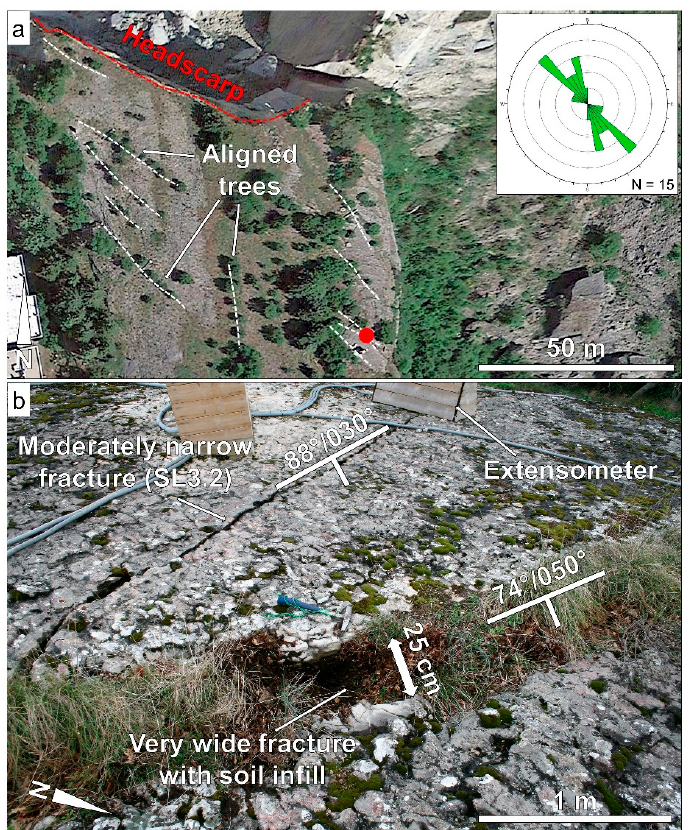
Figure 3. Fractures observed behind the San Leo landslide headscarp. ( a ) Plan view of the area behind the headscarp (2019 imagery from Google Earth). The red, dashed line outlines the 2014 rupture surface. White lines show the location of fractures. Red dot marks the location of the photograph in b; ( b ) Detail of two intersecting fractures. Fracture SL3.2 is parallel to the discontinuity SL3.1 observed in the headscarp. In the background, one of the extensometers monitoring fracture opening can be observed. Photograph summer 2016.